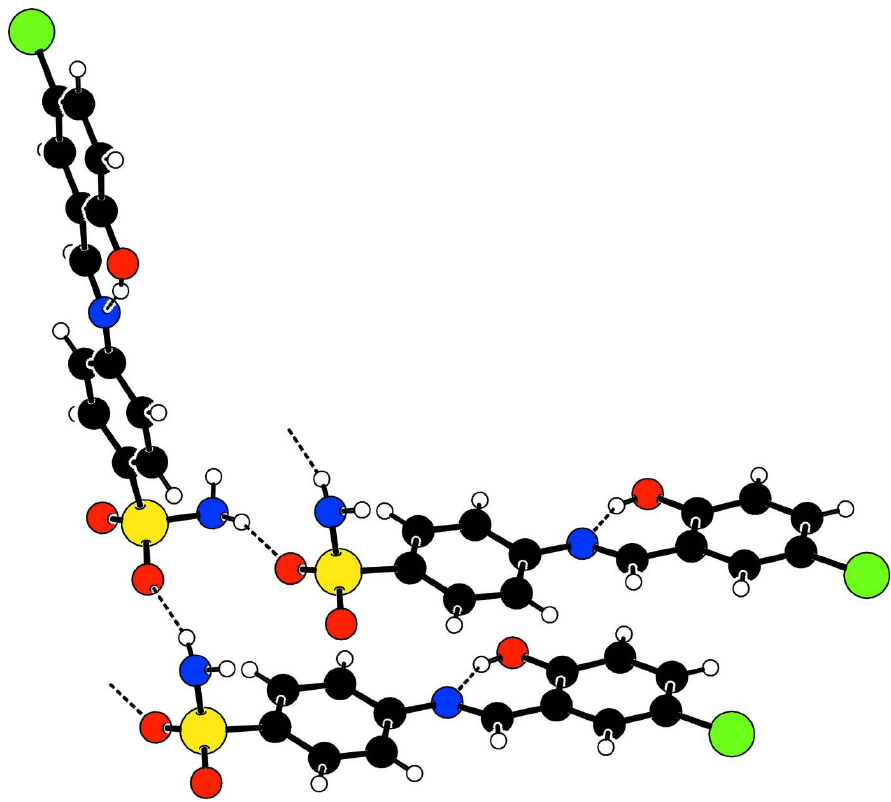
Figure 2 A partial packing diagram of the title compound. Hydrogen bonds are shown as dashed